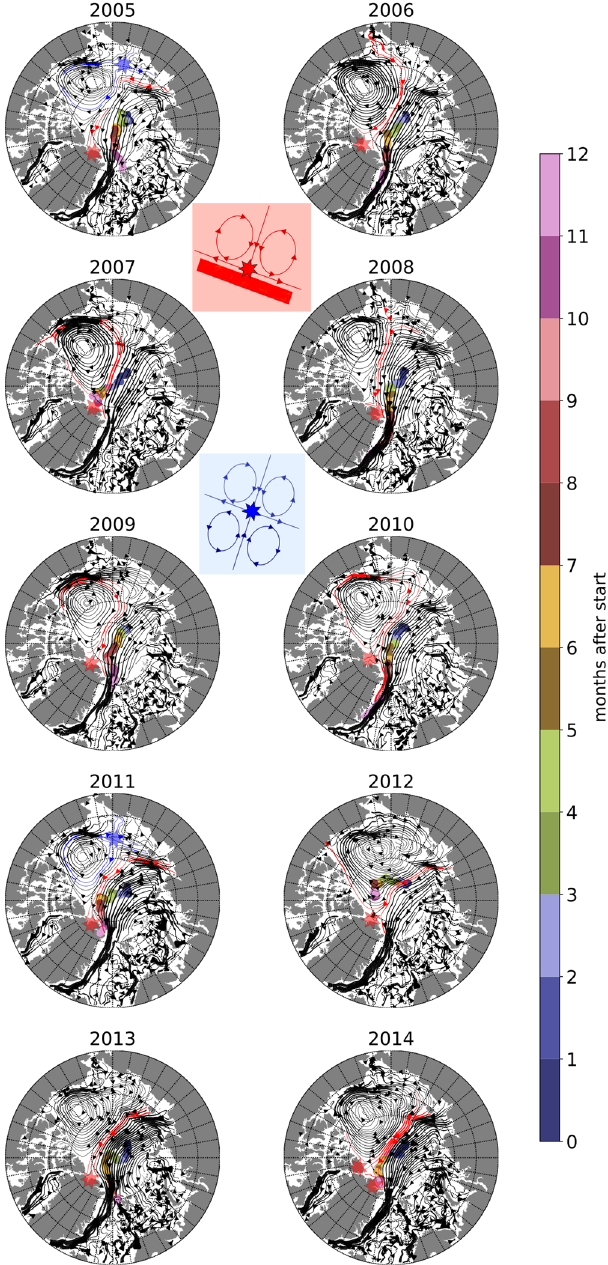
Fig. 3 Variation in annual pathways and surface fl ow structures in the Arctic. Ensemble-mean drift pathway for initial condition 6 October in each year, plotted daily over the following 12 months (colours). Streamlines show time-mean surface fl ow for the 12 month period, with line thickness proportional to fl ow speed (max. 0.2m/s). In regions of strong currents, where streamlines converge and obscure the underlying drift pathways, a zoomed view may be bene fi cial and Fig. 2 should also be used for reference. Inset are examples of saddle points near land (red star) and in the open ocean (blue star) and associated streamline topology ( fl ow direction may be reversed without altering the type of saddle point). Streamlines in the vicinity of saddle point examples are also coloured red and blue,